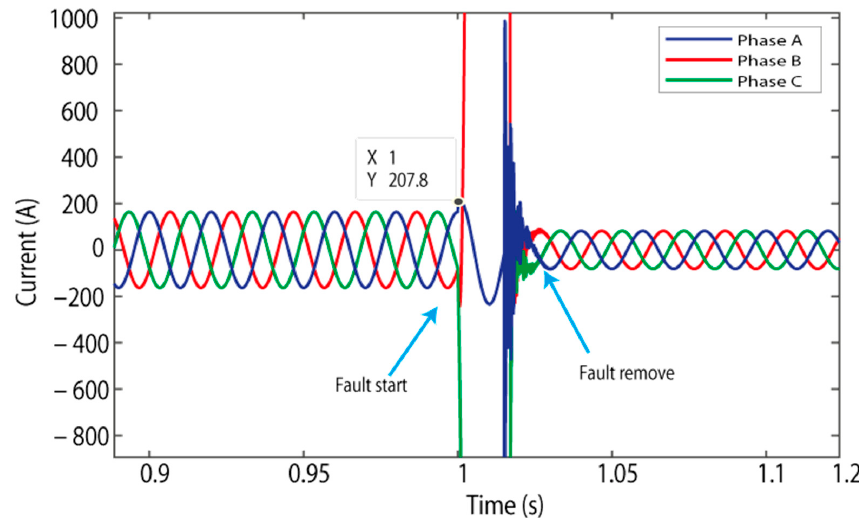
Figure 10. Responses of the system under fault and cyber-attack.